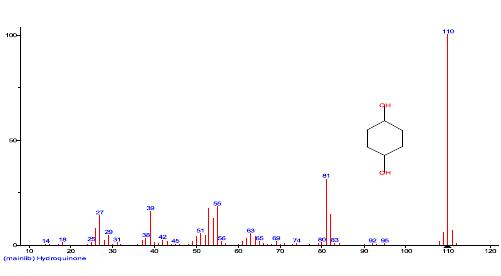
Fig. 9. The mass spectroscopy of compound (A) from